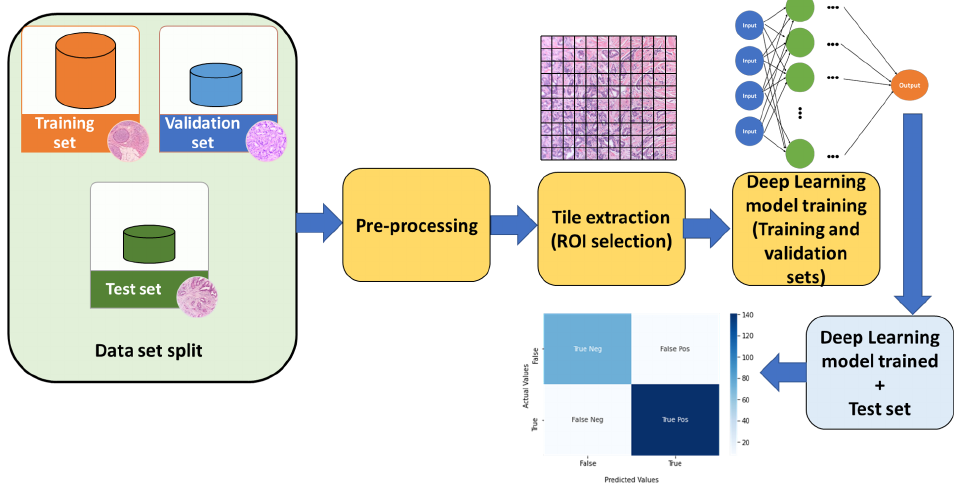
Figure 1. Illustring typical framework for pathology WSI classification with deep learning